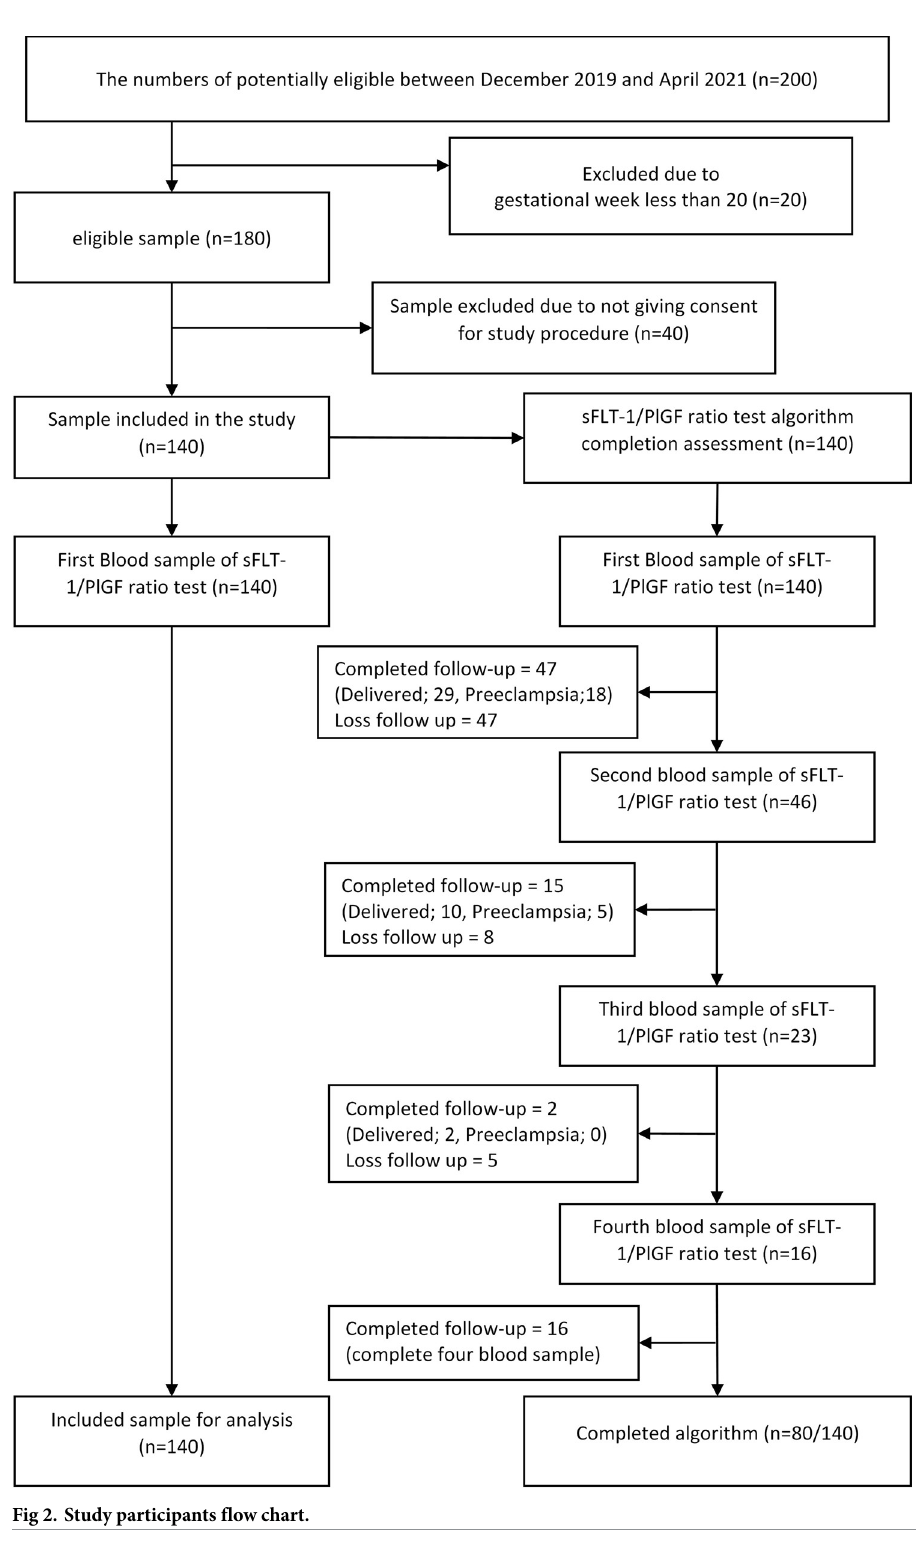
Fig 2. Study participants flow chart.